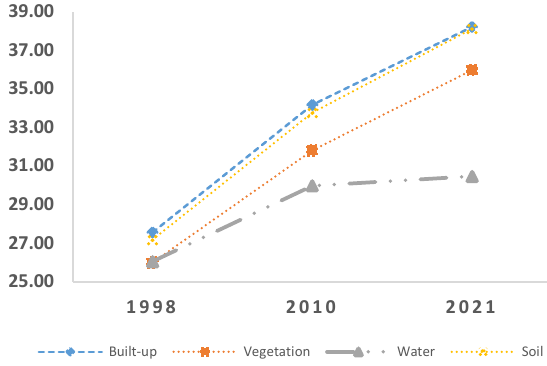
Figure 5 . Interaction plot for LST versus